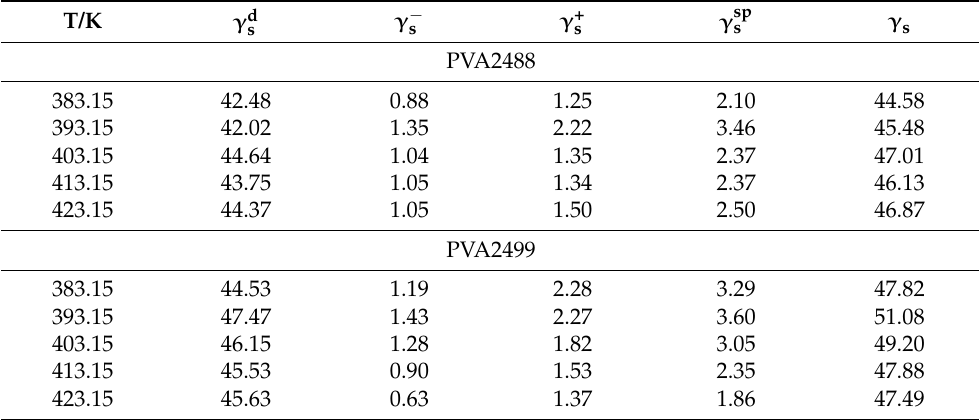
Table 8. Dispersive component γ d s , specific component γ d s , and total surface energy γ s of PVA2488 and PVA2499 at different temperatures.